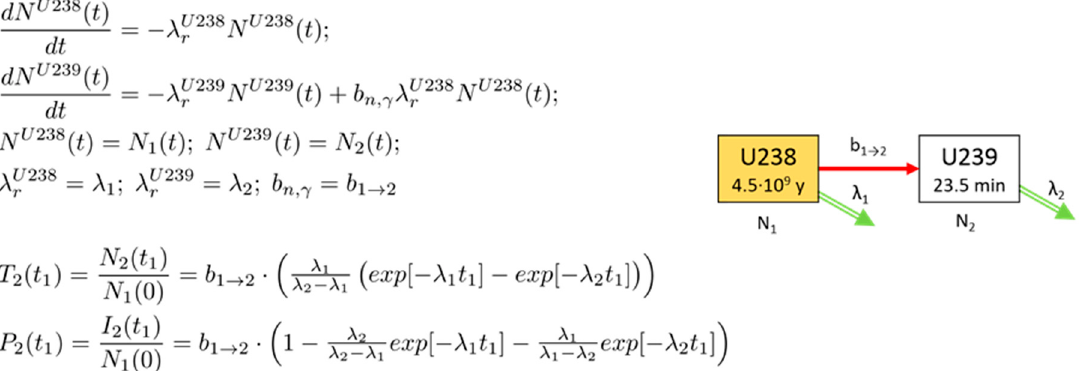
Figure 4. Second transmutation trajectory in the 238 U chain.